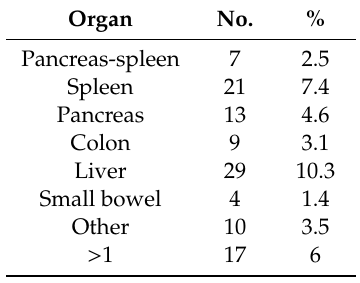
Table 2. Additional resections of organs apparently infiltrated by the tumor (cT4b).